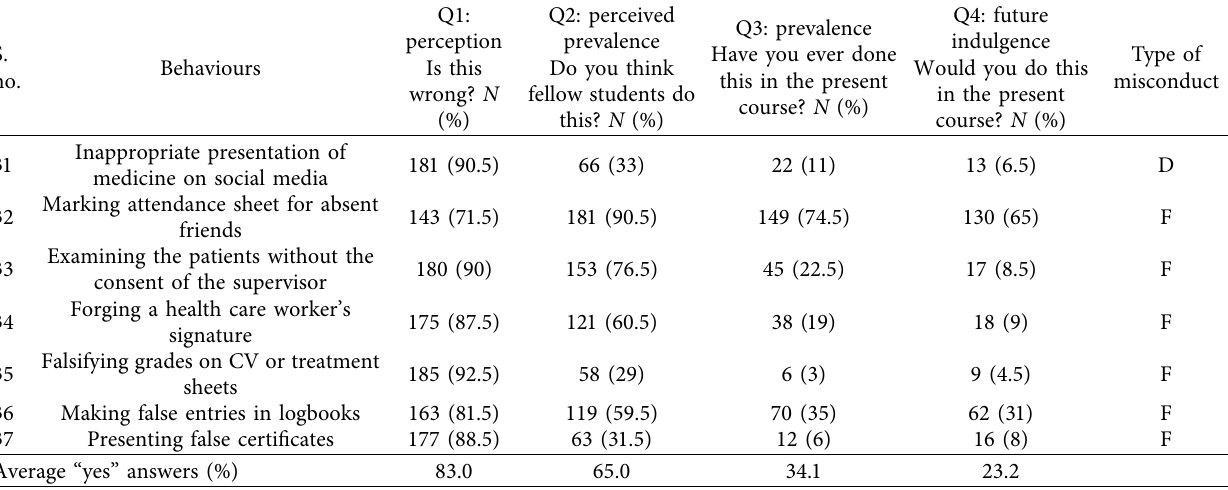
The table lists the 37 behaviors of Dundee Polyprofessional Inventory-1 customized for Pakistani medical colleges relating to academic misconduct. Four questions, Q1–Q4, were asked to the participants in yes/no format. The data presented here indicate the number of “yes” answers for each question. N represents the number, and % represents the percentage of participants of total ( N � 200) answering as “yes.” The types of misconduct are represented by plagiarism (P), indolence (I), cheating (C), disruptive behavior (D), and falsifying data